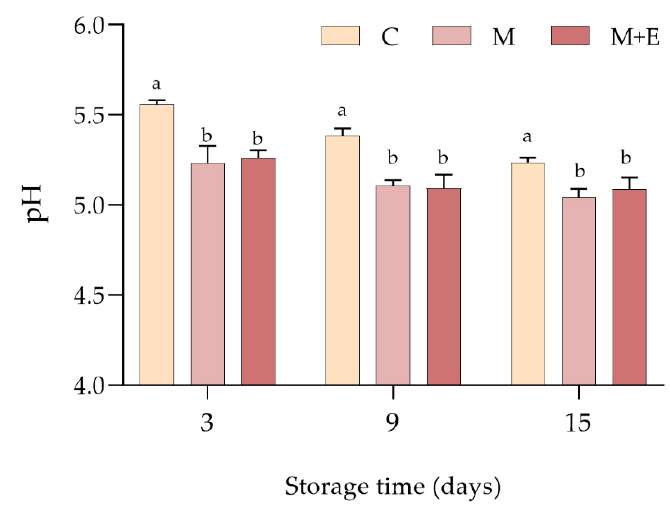
Figure 1. Average pH values of non-marinated (C), marinated (M) and marinated with essential oils (M + E) pork loin slices at 3, 9 and 15 days of refrigerated storage. Data represent means ± SD. a, b = average values lacking a common letter significantly differ among the same sampling time.